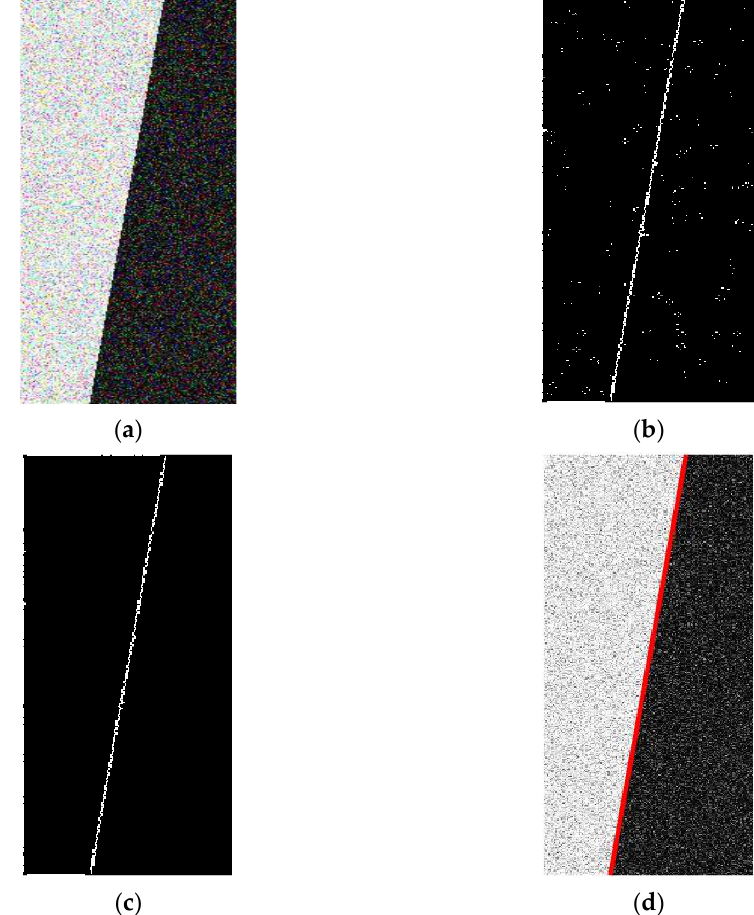
Figure 5. Sub-pixel edge detection results: ( a ) Edge image with noise variance of 0.1; ( b ) Sub-pixel edge detection results by traditional Zernike moments; ( c ) Sub-pixel edge detection results by Improved Zernike moment; ( d ) Detected edge straight line.